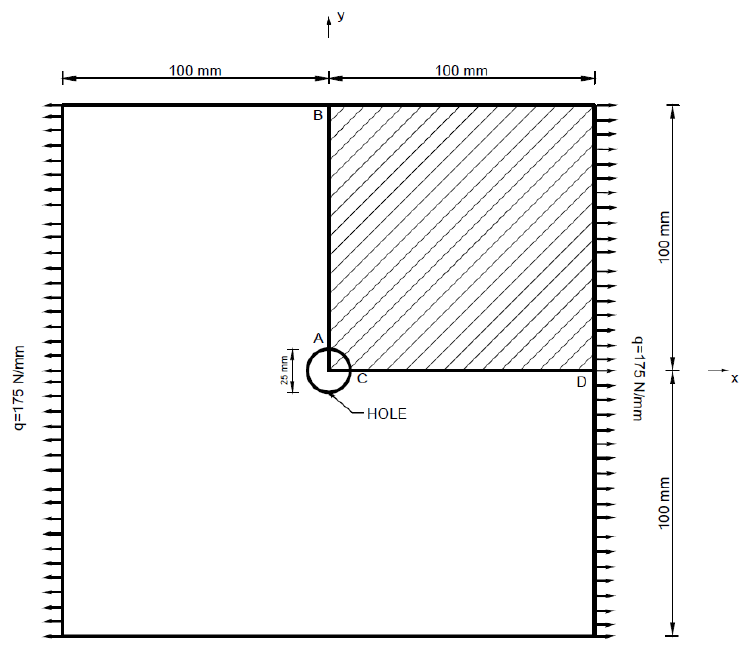
Figure 5. Structure 2: A plate with the hole in the middle.